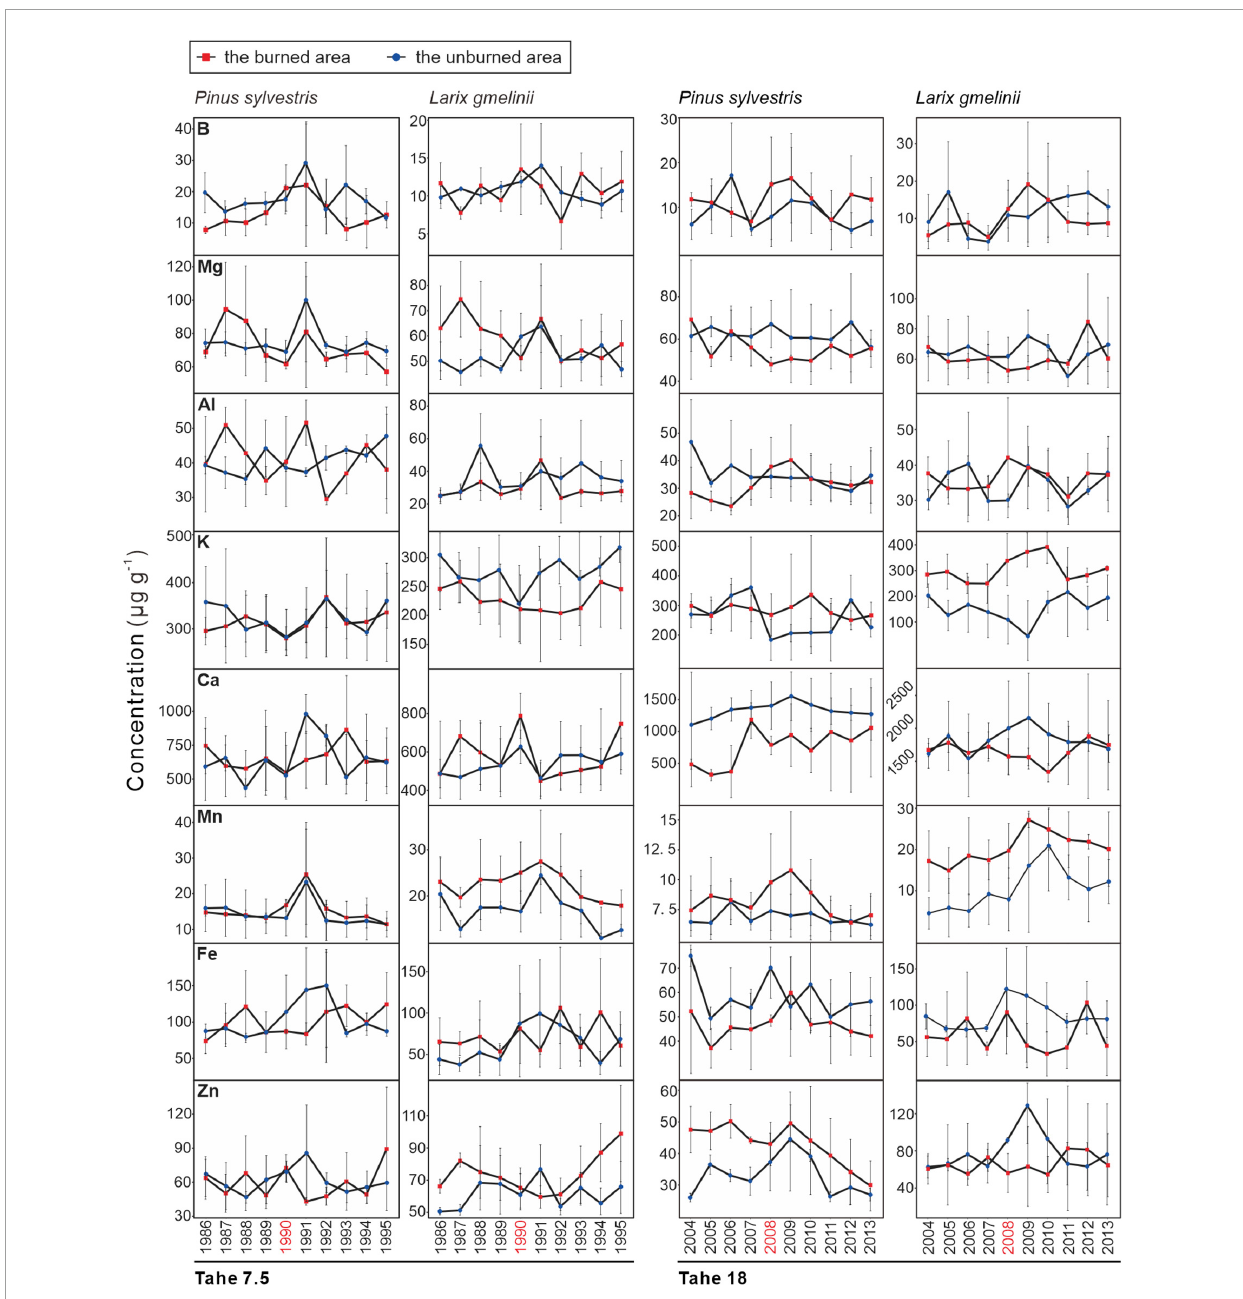
FIGURE3 Concentrations of elements in Tahe 7.5 (1986–1995) and Tahe 18 (2004–2013) in the burned area and unburned area.